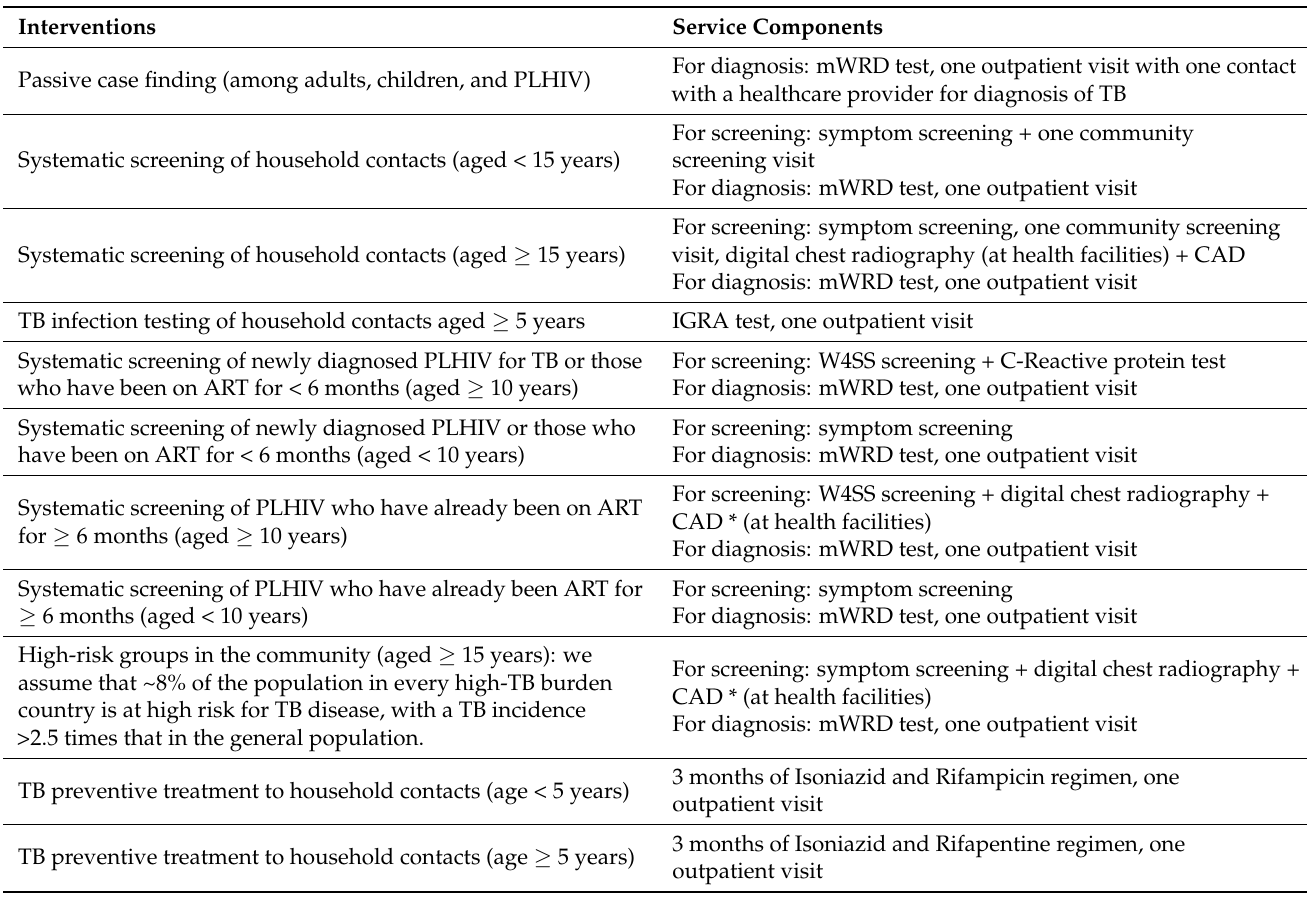
Table 3. Screening and prevention interventions and associated service components to estimate the funding required to achieve the UNHLM case detection and TPT